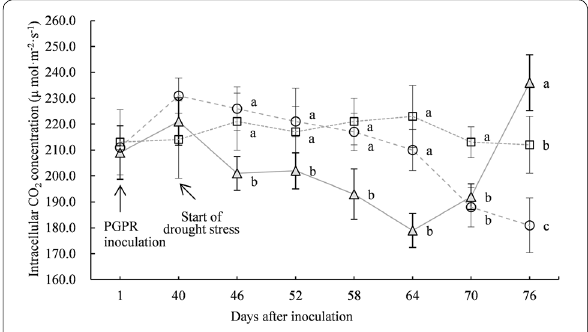
Fig. 2 Effects of Acinetobacter calcoaceticus X128 inoculation on the stomatal conductance of Sambucus williamsii Hance container seedlings under drought-stressed condition. Values are means of three repeating groups (twelve seedlings for each repeat group). Bars represent the standard deviation. Different letters indicate significant differences for the stomatal conductance on the same day after inoculation at P < 0.05 by LSD